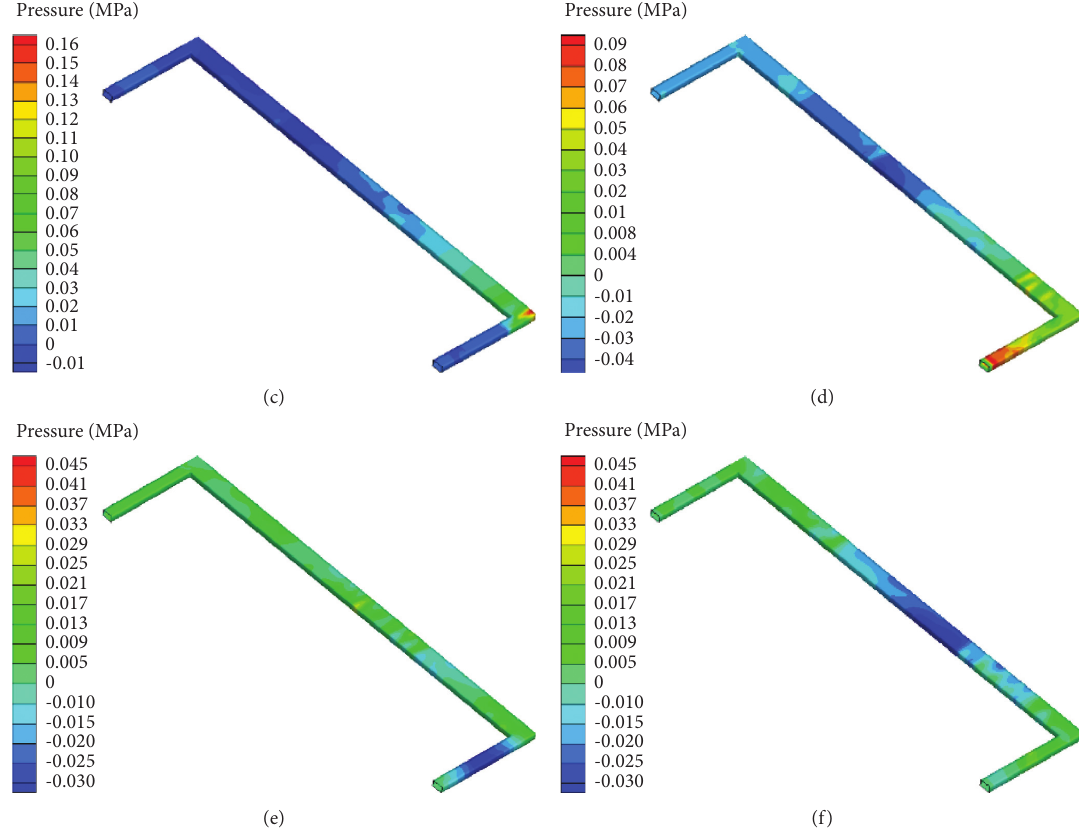
Figure 11: Pressure nephogram of shock wave at different times (rectangle): (a) t � 0.02s; (b) t � 0.15 s; (c) t � 0.36s; (d) t � 0.44s; (e) t � 0.6s; (f) t � 0.94s.